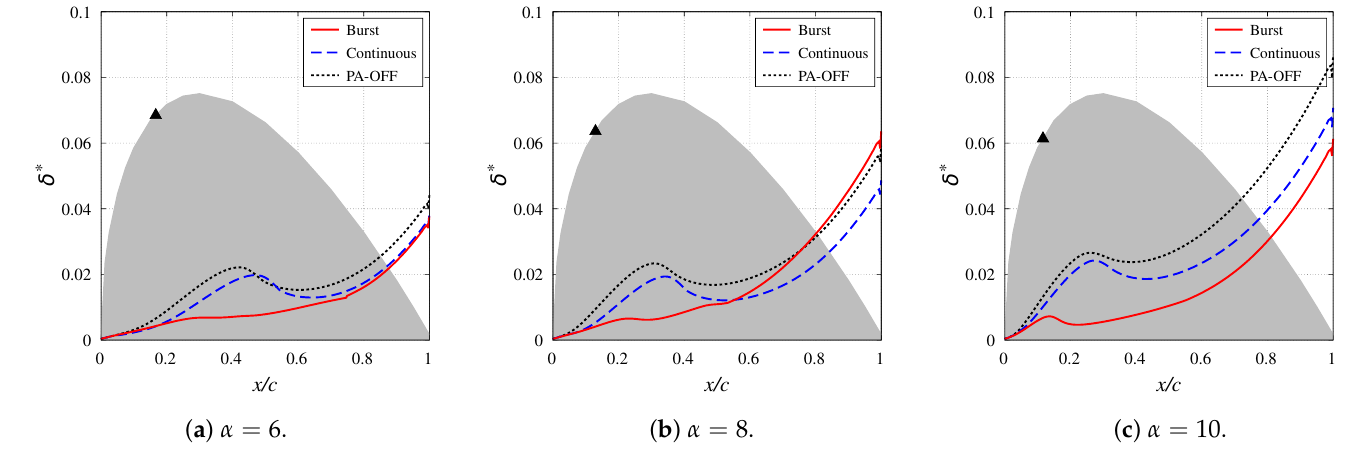
Figure 12. Displacement thickness ( δ ∗ ) on the airfoil’s upper